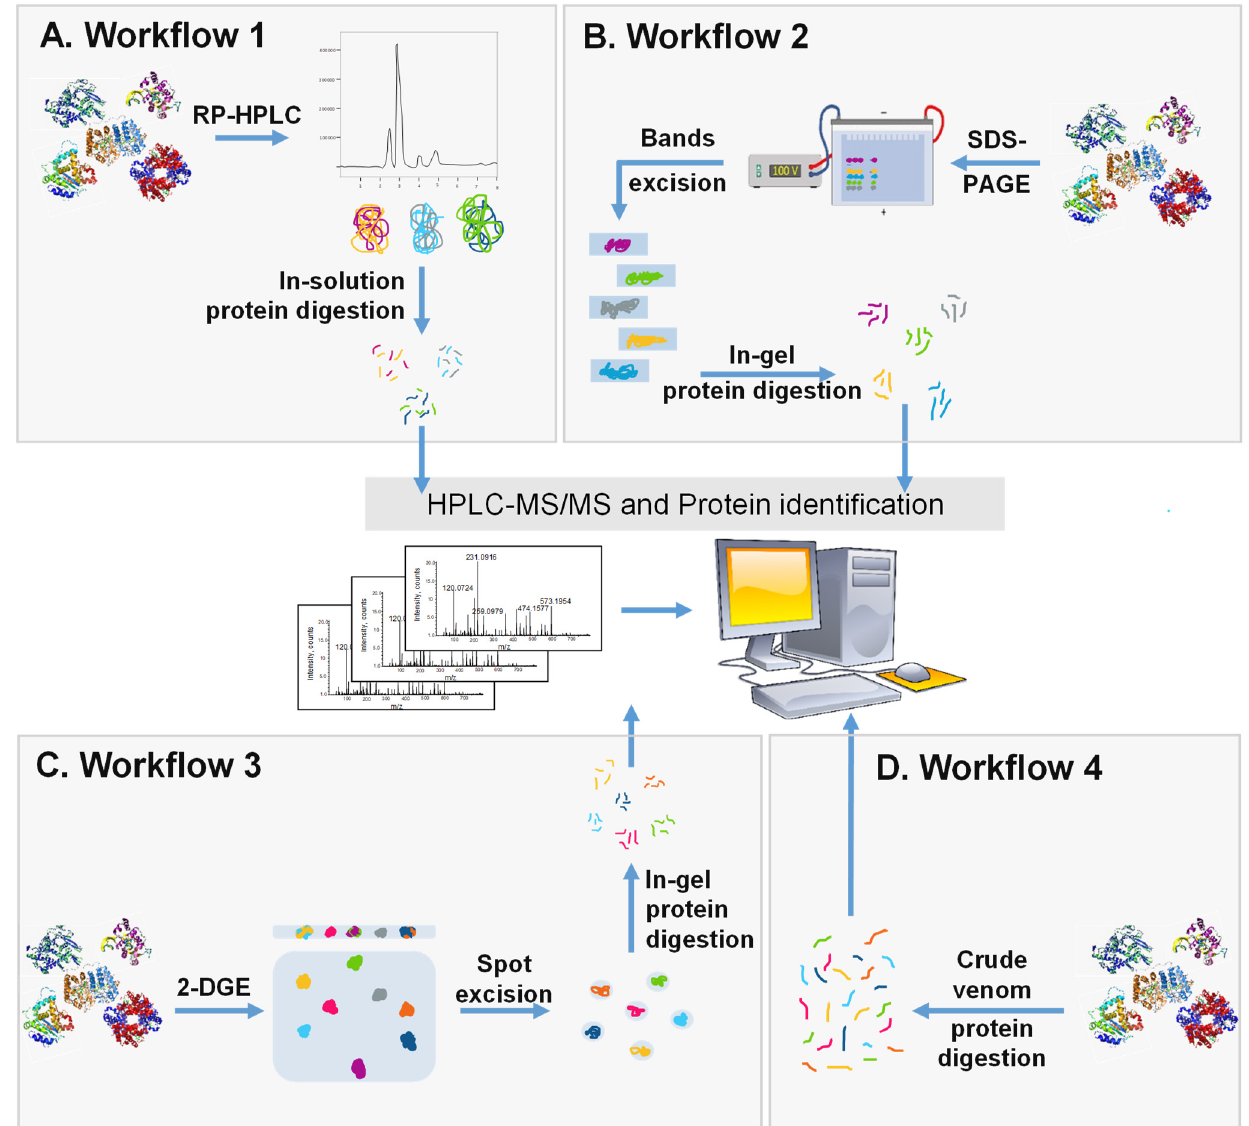
Figure 4. Schematic representation of the 4 major workflows used for whole venom separation and proteome identification. ( A ) Crude SV is separated with RP-HPLC followed by in-solution trypsin digestion and the identification of components by LC-MS/MS. ( B ) Crude SV is separated by SDS-PAGE and protein bands are cut, digested, and analyzed using LC-MS/MS. ( C ) Crude venom is separated using 2-DGE followed by protein spot excision, in-gel digestion, and then protein identification by LC-MS/MS. ( D ) Crude venom is directly digested into peptides and analyzed using LC-MS/MS.